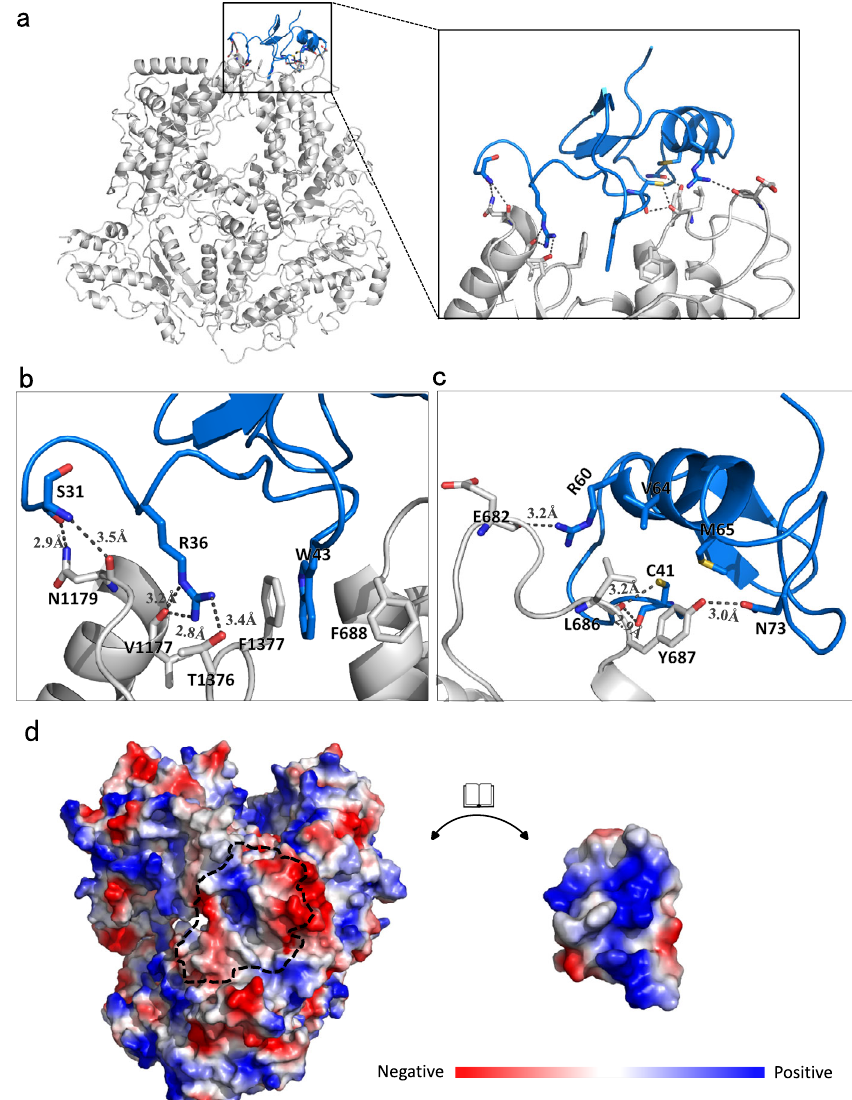
Fig. 4 Details of the molecular interactions between JUNV L and Z protein. a A cartoon representation of JUNV L – Z complex structure is shown, with L shown in gray and Z in blue. The black boxes indicate the magni fi ed view of the interactions between L and Z. b , c Magni fi ed views of interaction interfaces between L and Z. The representative residues involved in the interaction are shown, main chain or side chains involved in hydrogen bonds or hydrophobic interactions are shown as sticks, with oxygen, nitrogen and sulfur atoms shown in red, blue and yellow, respectively. Hydrogen bonds are depicted as black dashed lines. d L and Z are shown as molecular surfaces colored by electrostatic potential from red to blue, negative to positive, respectively. The surface of each protein is shown in an open-book representation. The approximate binding interface is outlined by a black dashed